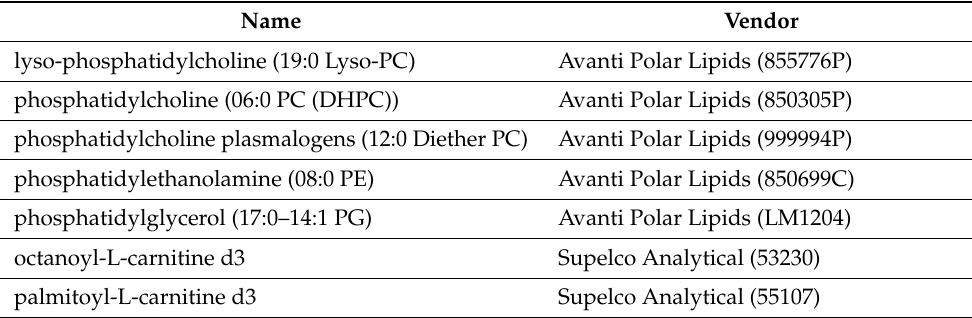
Table 2. Internal standards used for lipidomics analysis.